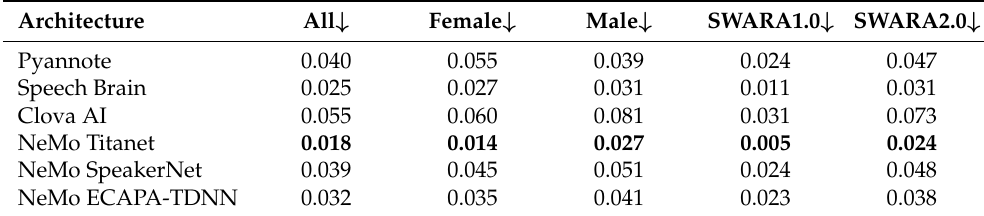
Table 1. EER values for the different speaker embedding architectures and speaker subsets. Arrows mark the direction of best performance. Best results are highlighted in